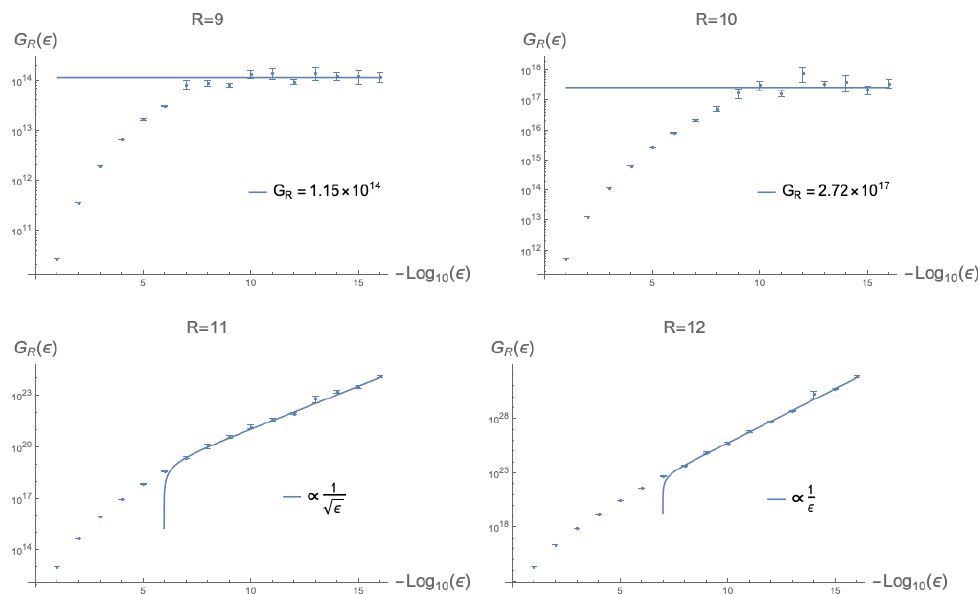
Figure 5. An example of the verification of R c and the determination of the numerical value of G R . This is the case for symmetric tensors, with K = 3 and N = 3. The dots (with error bars) represent the − Rc measurements, and the fitted curves are C ∗ (cid:101) − R 2 + const . for R > R c as in (29), and the constant value G R for R ≤ R c as in (10). This clearly shows that, in this case, R c =